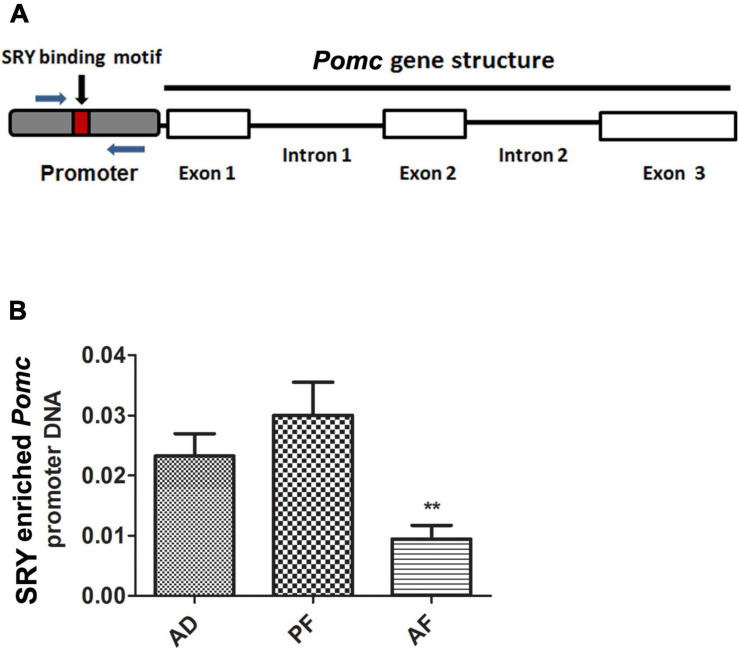
SRY recruitment onto the Pomc promoter in MBH of FAE rat offspring. A schematic diagram of Pomc gene structure comprising three exons and promoter. A small box within the promoter sequence represents the SRY binding motif. Arrows represent the ChIP primers spanning the SRY binding motif in Pomc promoter (A). SRY recruitment onto the Pomc promoter in MBH of AD, PF, and AF rat offspring were measured by ChIP assay. SRY-enriched Pomc promoter DNA was amplified by quantitative RT PCR using primers specific for Pomc promoter. SRY-enriched Pomc promoter DNA was normalized with input DNA (B). Data are mean ± SEM (n = 6) and were analyzed using one-way ANOVA with the Newman-Keuls post hoc test; **p < 0.01 between AF and controls (AD, PF).